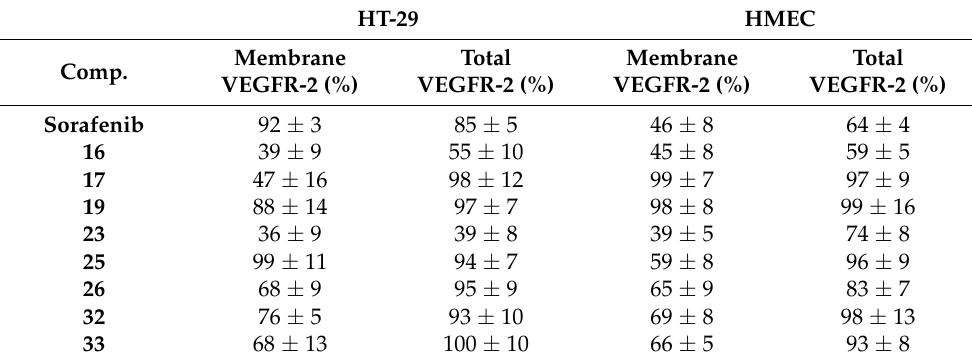
Table 2. Effect on VEGFR-2 expression in HT-29 and human microvascular endothelial cells (HMEC)